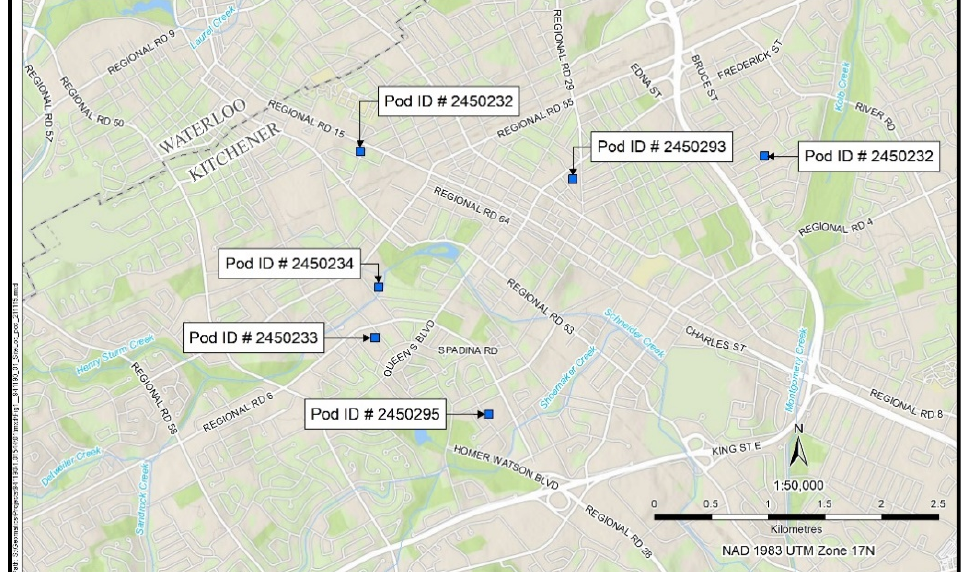
Figure 1. Spatial location of multisensor pods in Kitchener, ON. Pod 2450233 and Pod 2450293 are located near major roads. Pod 2450232 was located downwind from a factory (western location,